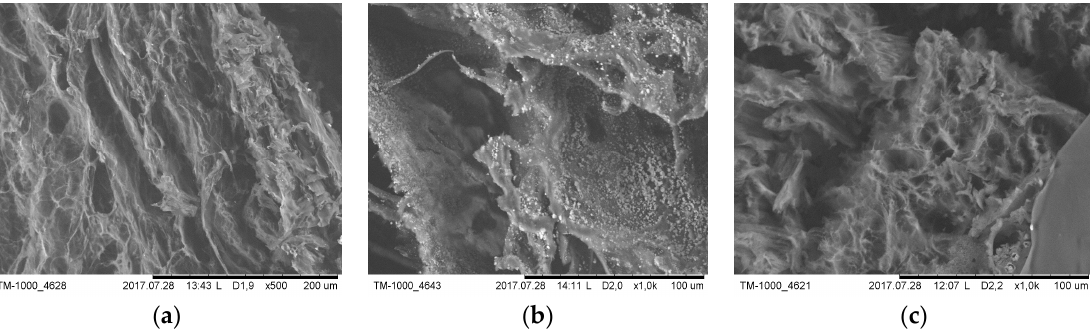
Figure 9. SEM images of freeze-dried CS - g - PNIPAAm/PVA 75/25. ( a ) Image of gel formulation before stability test, ( b ) image of gel formulation loaded with Voriconazole, ( c ) image of freeze-dried gel formulation after two months conditioning.